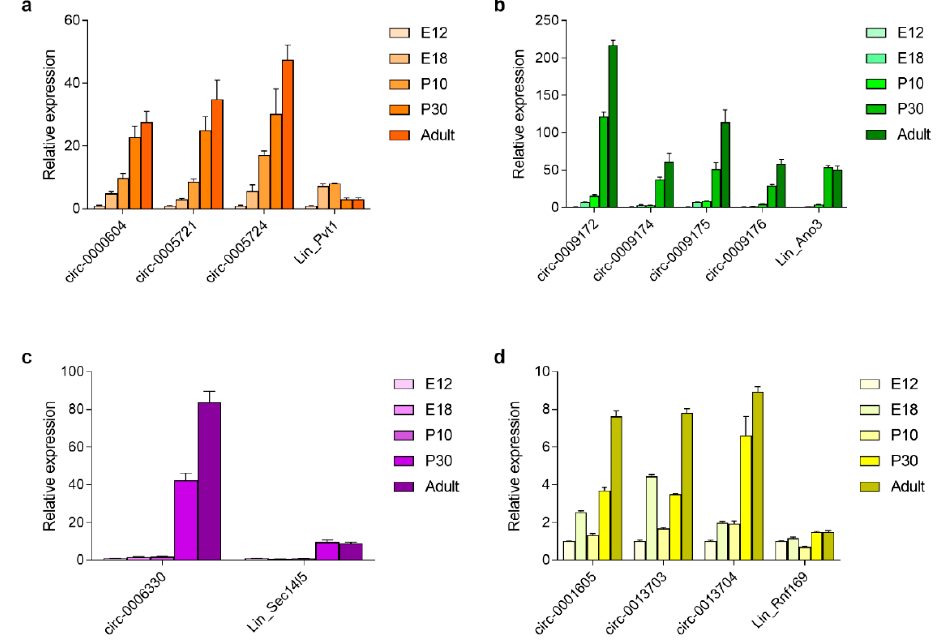
Figure 5. RNA expression during embryonic and post-natal brain development. Relative expression of linear and circular transcripts of ( a ) Pvt1; ( b ); Ano3; ( c ) Sec14l5; and, ( d ) Rnf169 in the brain at different developmental stages. Expression at E12 was set at 1. Data shown are means + s.e.m. of four biological replicates ( n = 4).